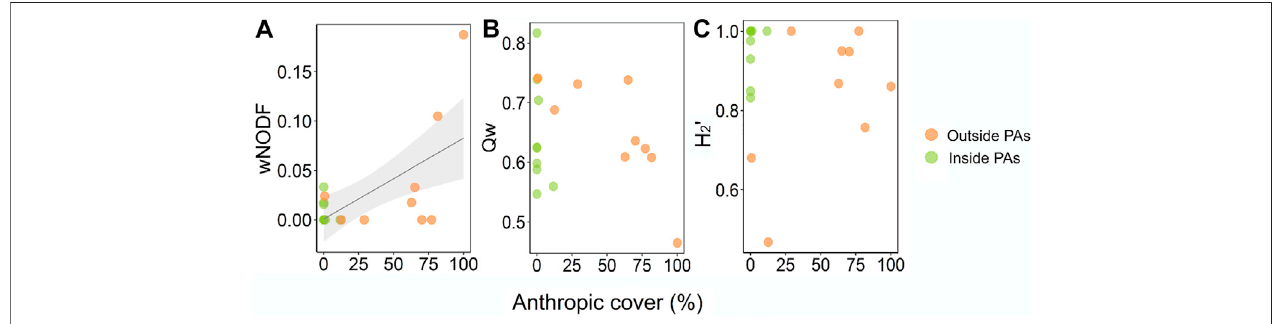
FIGURE 2 | Distribution of structural metrics from bat-bat fl y interaction networks along an anthropization continuum in Central Brazil. (A) : nestedness; (B) : modularity; (C) : complementary specialization. Networks are divided according to their position in the landscape (inside or outside Protected Areas). Points with denser colors indicate overlapping